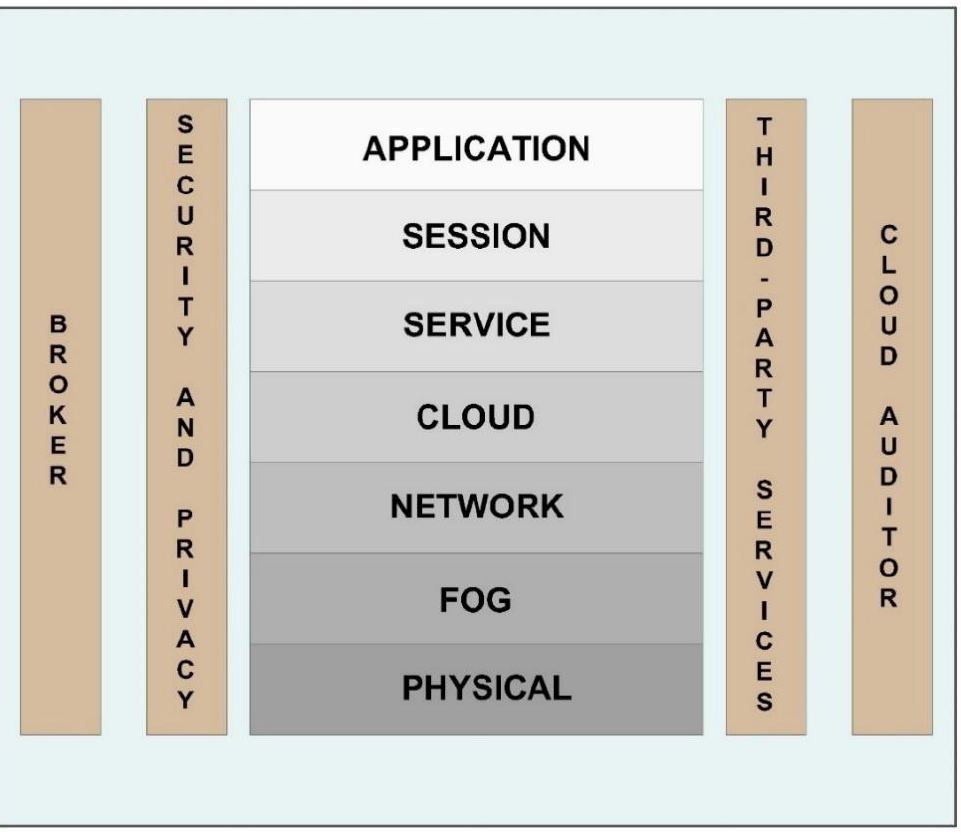
Figure 2. Energy cloud management layout.